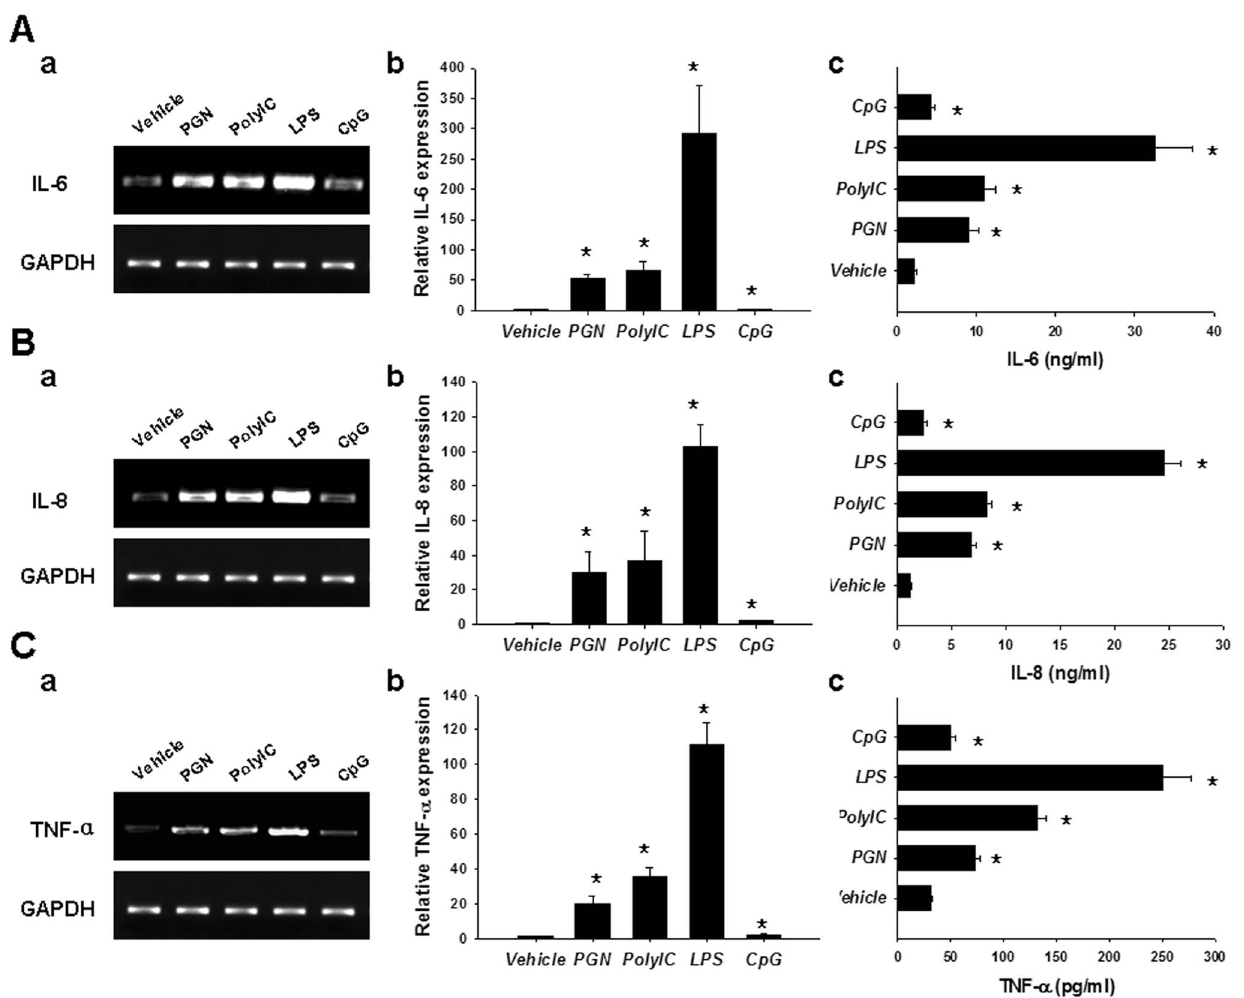
Figure 2. TLR agonists promoted RASF to produce inflammatory cytokines. RASF were stimulated with TLR2 agonist PGN (10 m g/ml), TLR3 agonist ploy(I:C) (25 m g/ml), TLR4 agonist LPS (100 ng/mL), or TLR9 agonist CpG (10 m g/ml). 4 h later, the cells were harvested for RT-PCR (A–C, a) and realtime PCR (A–C, b) analyses of IL-6, IL-8, and TNF- a ; 24 h later, the cell culture supernatants were collected for ELISA analyses of IL-6, IL-8, and TNF- a (A–C, c). The results were presented as mean + SEM of five independent experiments (Wilcoxon signed-rank test, * P , 0.05 vs. vehicle